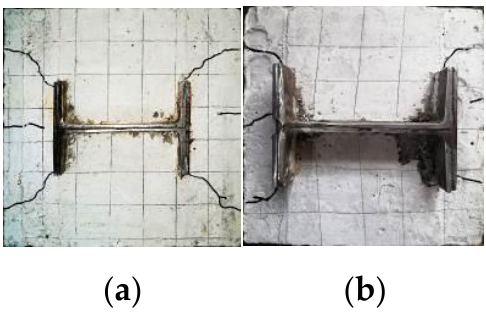
Figure 5. Expansion cracks. ( a ) S-SFRAC12. ( b ) S-SFRAC14.